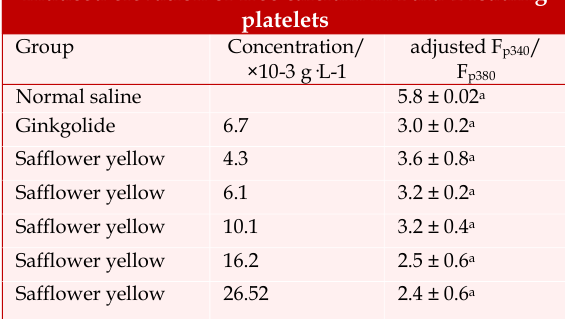
Effect of safflower yellow on PAF (8.0×10 -10